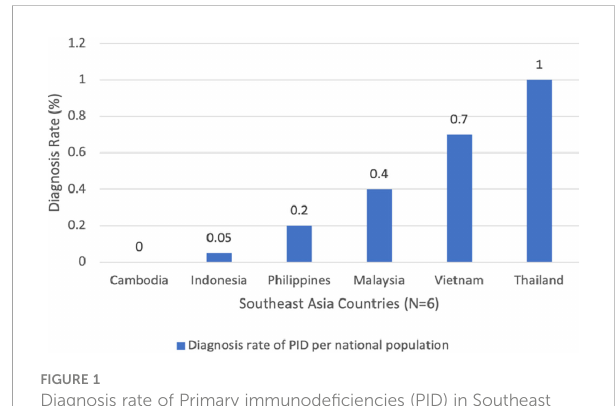
FIGURE 1 Diagnosis rate of Primary immunode fi ciencies (PID) in Southeast Asia (SEA). Notes: The diagnosis rate of different countries are calculated based on the known number of patients and the theoretical number of PID patients in each country (based on a prevalence rate of 1 in 2, 000 inhabitants). The diagnosis rate is expressed in